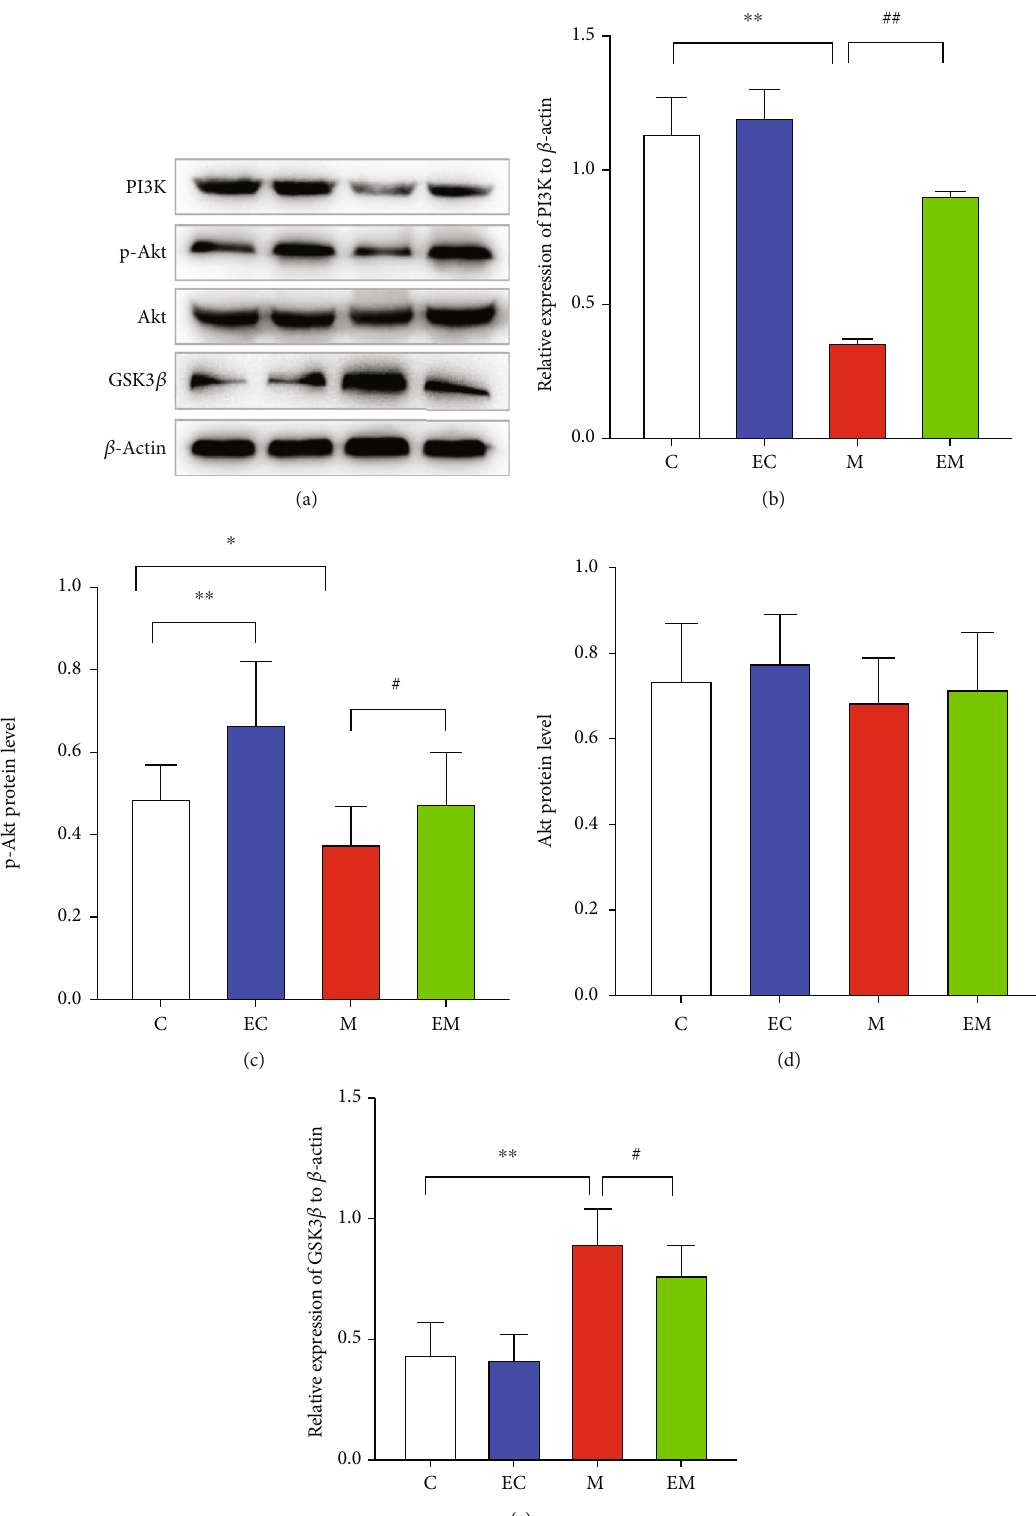
Figure 4: Hippocampal PI3K, p-Akt, Akt, and GSK-3 β protein expression in various groups of mice. (a) PI3K, p-Akt, Akt, and GSK-3 β Western blot images. (b – e) PI3K, p-Akt, Akt, and GSK-3 β expression levels in each group of mice. β -Actin was used as an internal reference protein, and the data are mean ± SD ( n = 8/group ). ∗ P < 0 : 05 and ∗∗ P < 0 : 01 vs. group C; # P < 0 : 05 and ## P < 0 : 01 vs. group